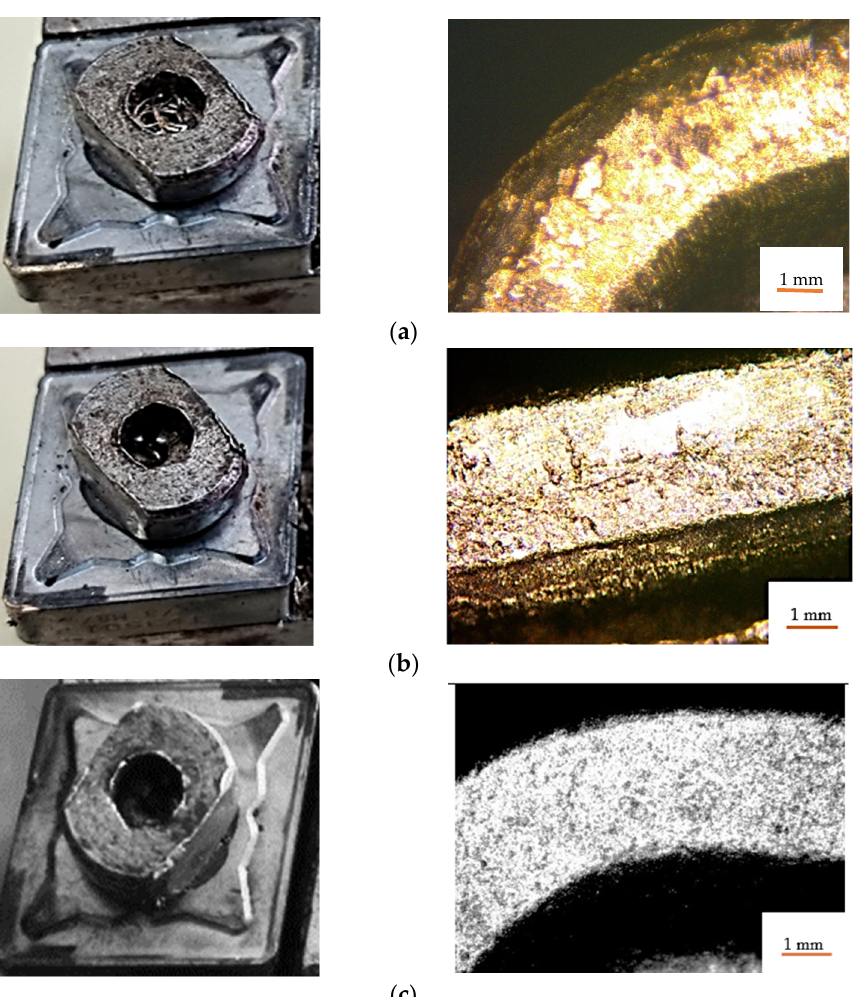
Figure 6. Deposits of processed material on the tool edge: ( a )—for tool V01; ( b )—for tool V02; ( c )—for the tool V03.